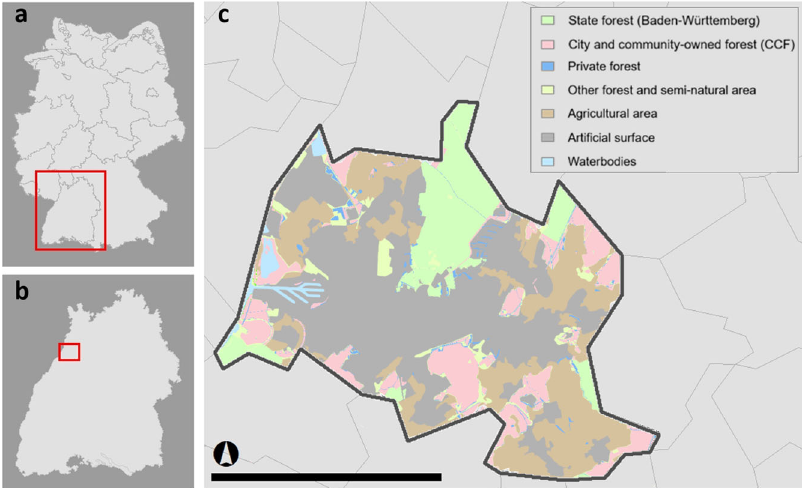
Fig. 4 Map of Karlsruhe by land use and forest ownership types. Own illustration based on LFV 81 . Scale bar in c represents 10 Table 2. Classi fi cation of the interviewed stakeholders according to the identi fi ed groups. Stakeholder group